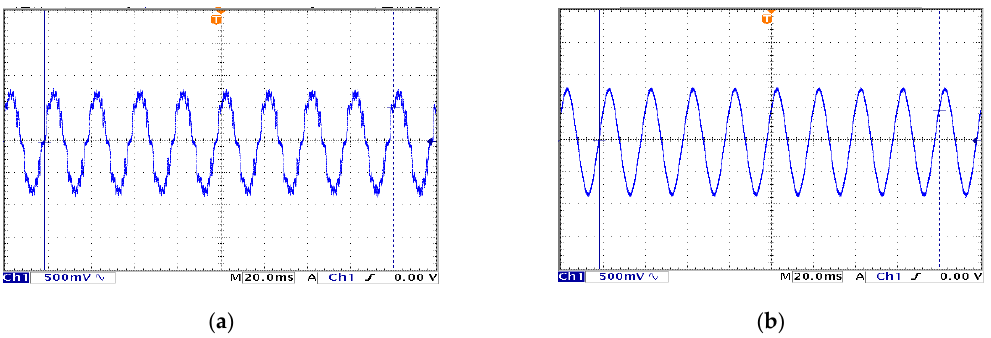
Figure 19. Current waveform in the grid without the micro-grid. ( a ) Load side current waveform. ( b ) PCC side current compensated waveform.